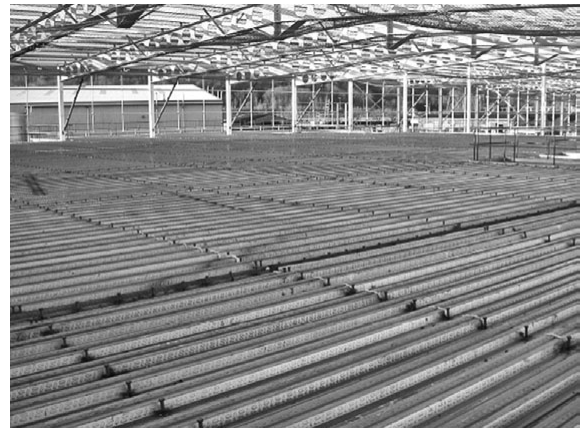
Fig. 1. A typical example of composite steel-concrete slab befo-re concreting, showing profiled decking placed on a steel frame